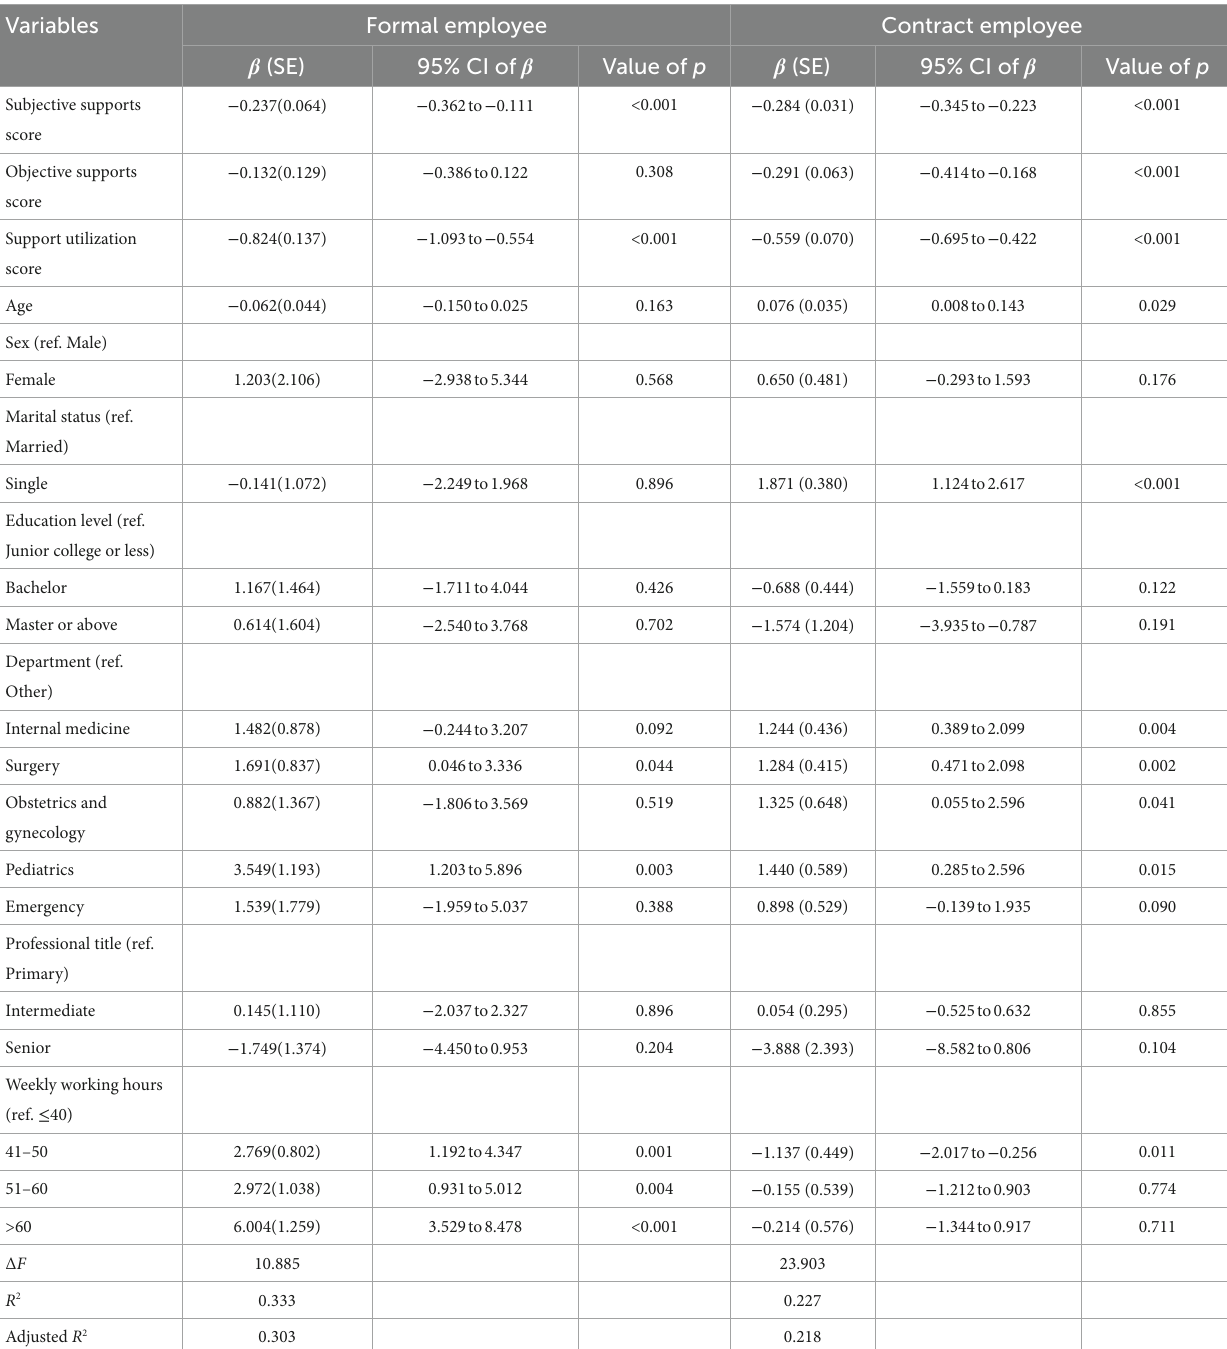
TABLE 4 Multiple linear regression model testing the association between social support and depressive symptoms among formal employee and contract